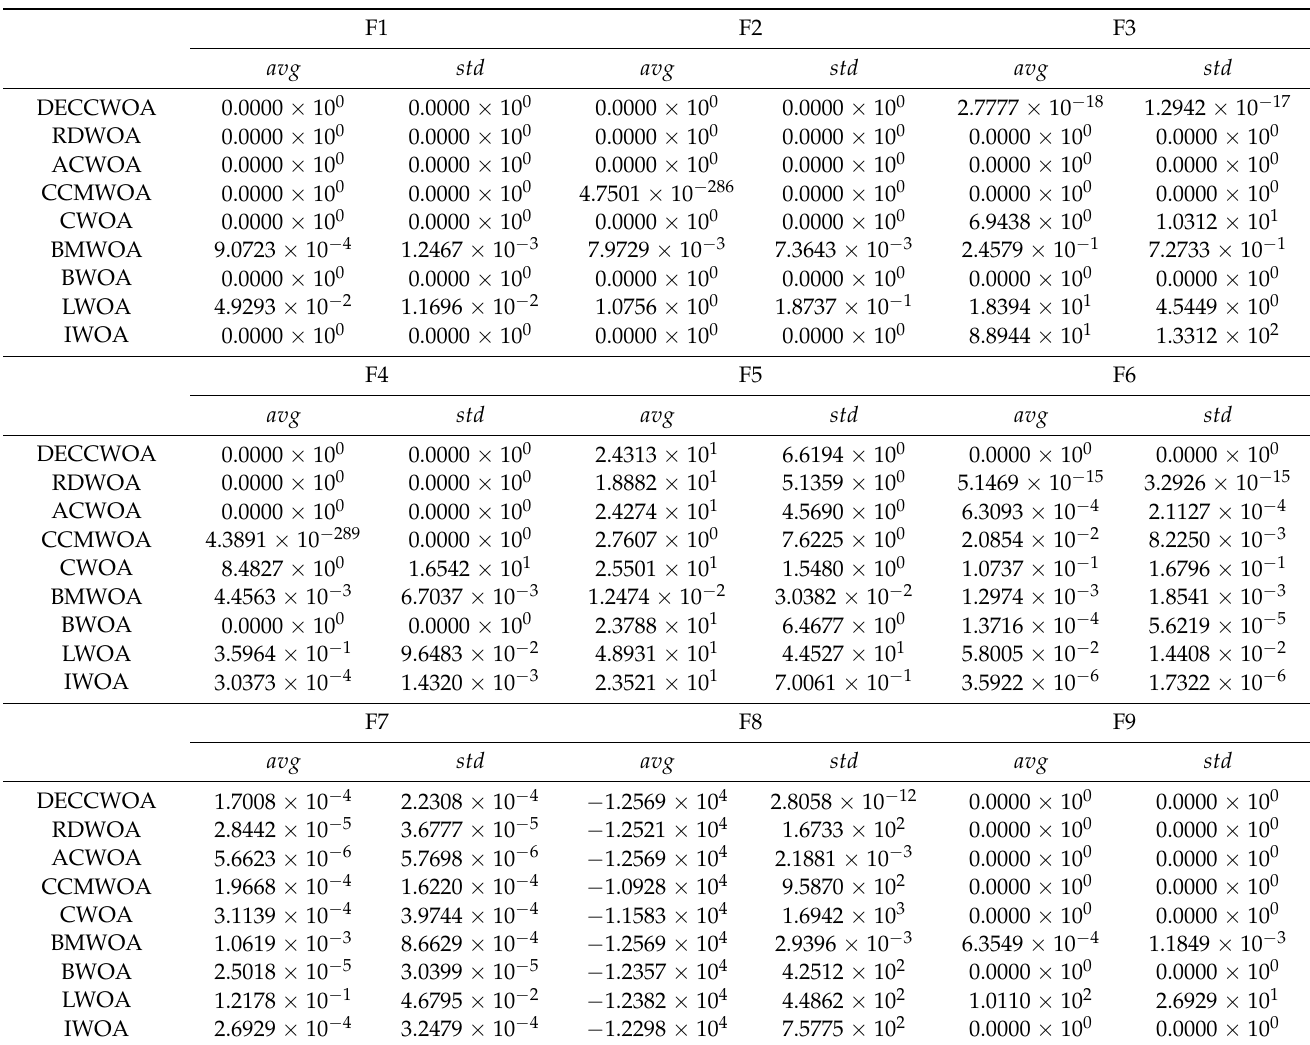
Table A4. Comparison results for the DECCWOA with improved WOA